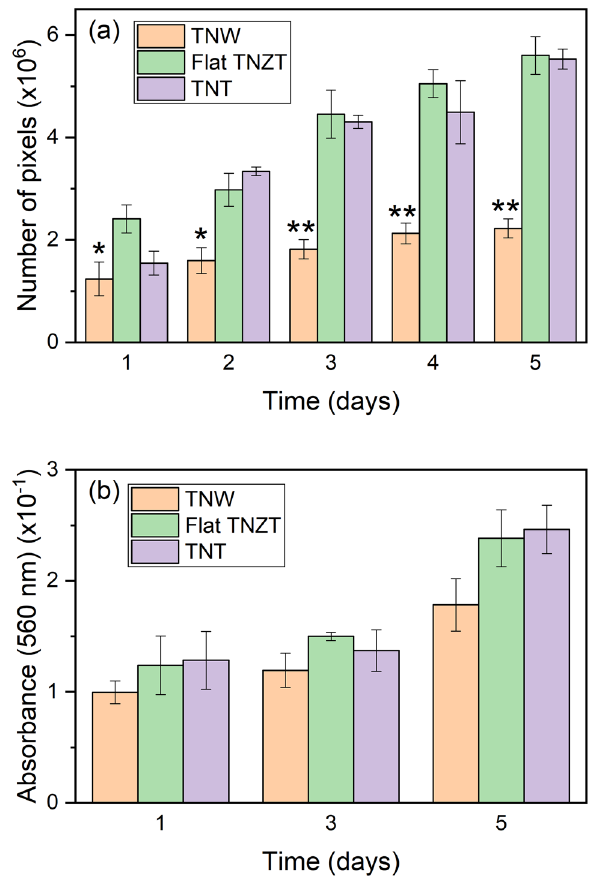
Figure 6. Proliferation and viability of MC3T3-E1 cells after different times of culture on the surfaces of the TNW and control samples (flat TNZT and TNT), as assessed by fluorescence microscopy ( a ) and by the MTT assay ( b ). Values represent the mean ± SEM of three independent experiments. * P ≤ 0.05, ** P ≤ 0.001 vs. flat TNZT samples (two-way analysis of variance, followed by Dunnett’s post-hoc